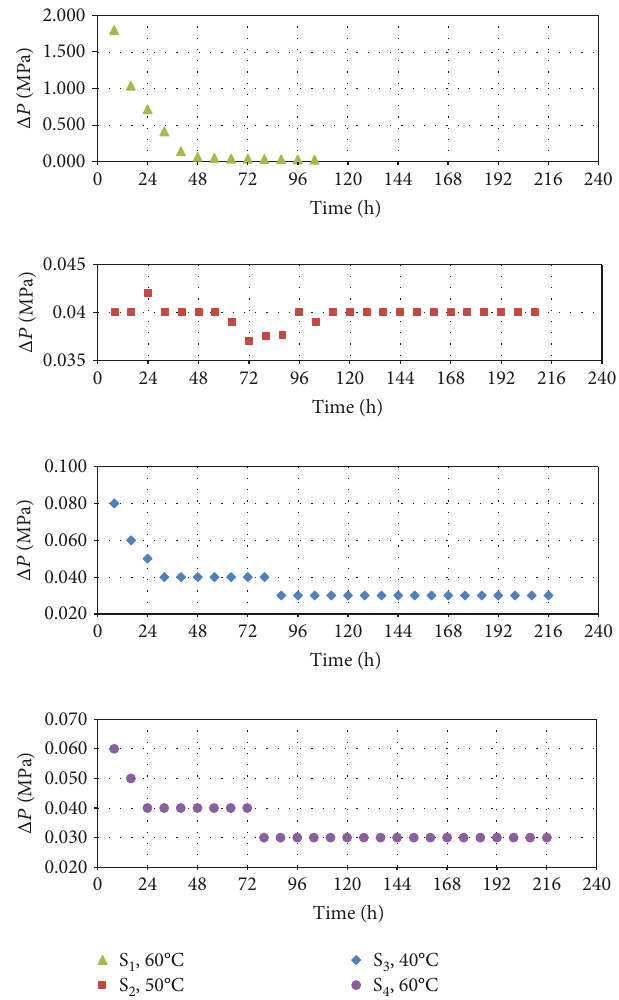
Figure 7: Variation process of the pressure di ff